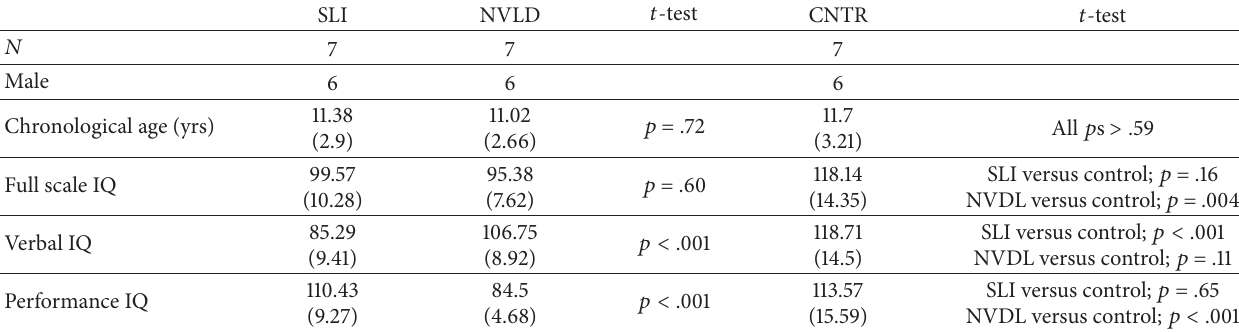
Table 3: Characteristics of participants included in the SPM analysis. Standard deviations in